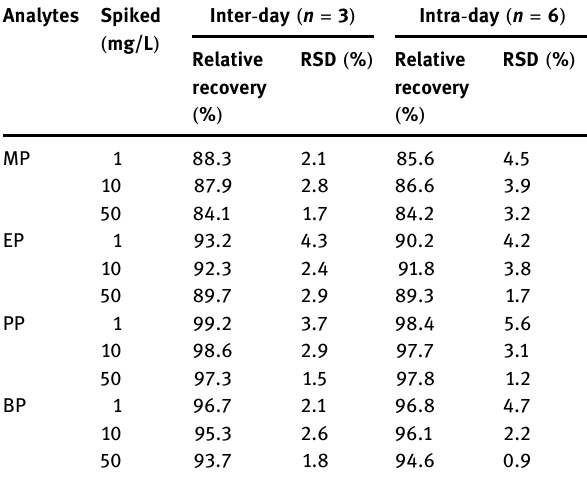
Table 3: Intra - day and inter - day recoveries and relative repeat - ability standard deviation of analytes in cosmetic samples Analytes Spiked ( mg/L )